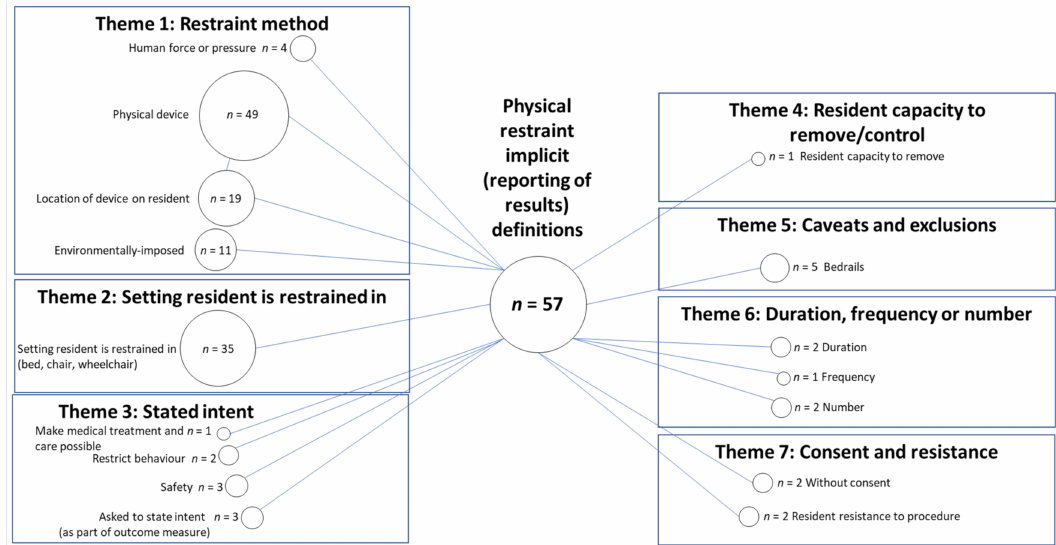
Figure 4. Codes and themes present within implicit definitions, based on reporting of results for physical restraint. n = number of reported results for which this code was